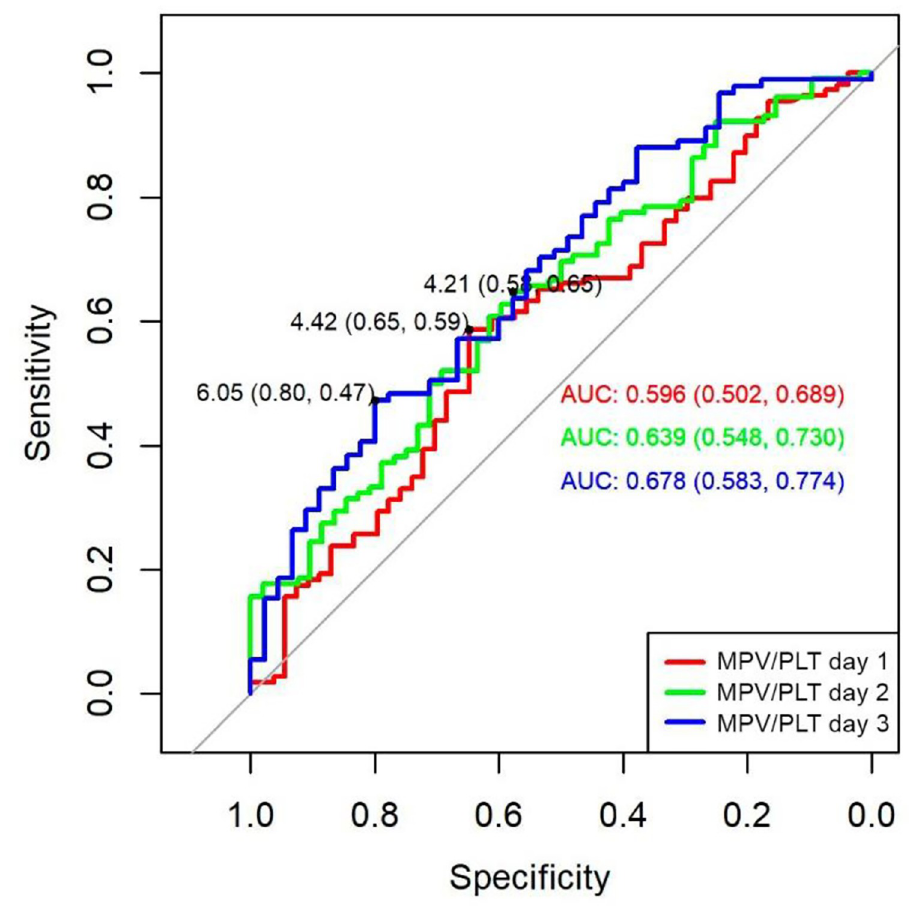
Fig 2. ROC curve of MPV/P ratio to predict septic shock in septic patients. AUC: area under the curve.